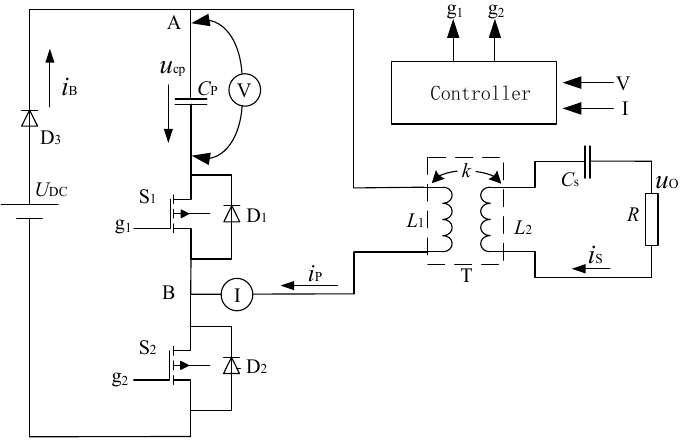
Figure 5. The structure of IIEIFR converter.